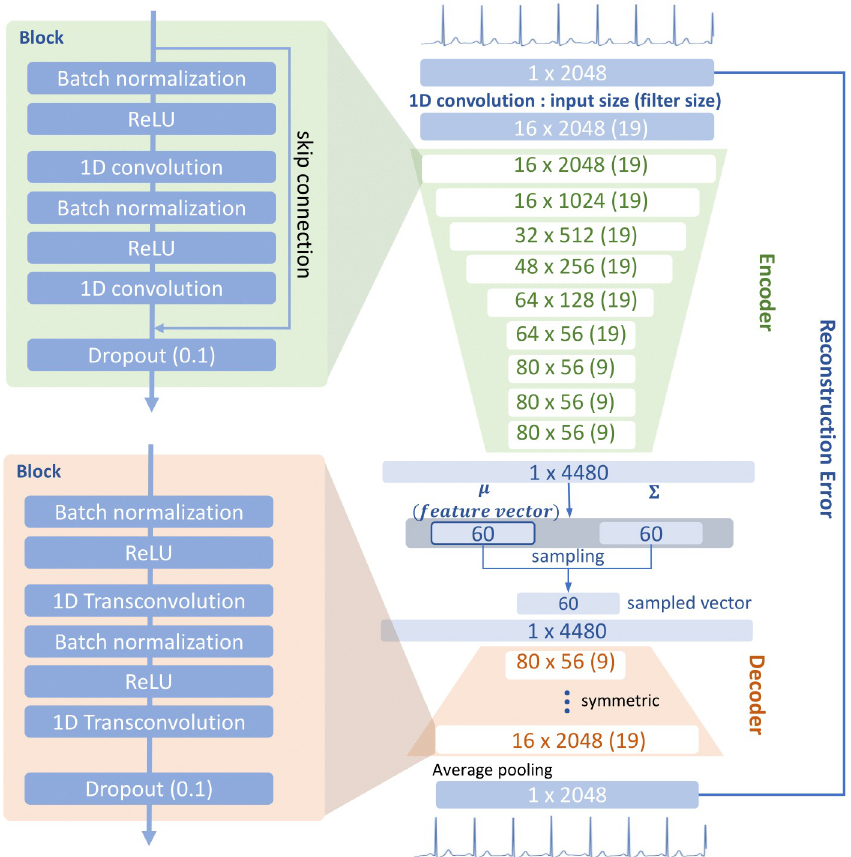
Fig 1. Model architecture of encoder in convolutional variational autoencoder (CVAE) consists of nine layers of one-dimensional convolutional neural network (CNN). The filter size is 19 until the sixth residual block, after which it is reduced to nine. At the end of encoder, the extracted data are flattened and converted into the values of mean and standard deviation with a size of 60. The latent variable is sampled from the values of mean and standard deviation. The hyperparameter of the decoder is set symmetrically so that the output size is the same as that of the encoder. Average pooling is applied to the outputs of the decoder. The mean values were used as the CVAE feature vector of electrocardiogram